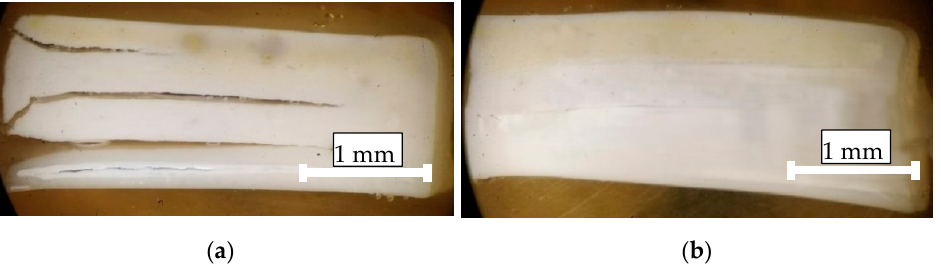
Figure 7. Cross-section images of ceramics subjected to electron beam irradiation. ( a ) is cross-sectional images of samples with an equal layer thickness; ( b ) is cross-sectional images of samples with an different layer thickness.